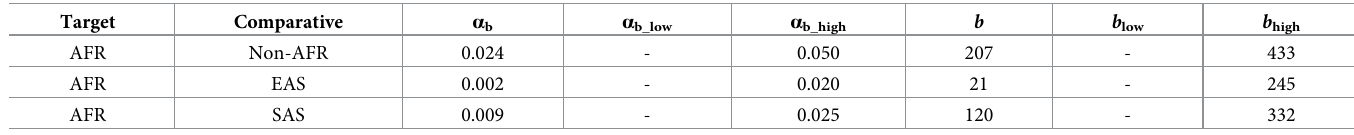
Table 5. Balancing selection in non-HLA genes. Estimates of the proportion of shared nonsynonymous polymorphisms under balancing selection, α b , in non-HLA genes, and the number of polymorphisms being directly maintained by balancing selection, b , for population comparisons in which Z > 1 when using all genes. Missing values indicate the lower confidence interval was less than 1. Data consist of 19,212 genes. Code to extract and analyse the data can be found at https://github.com/ vivaksoni/test_for_balancing_selection.